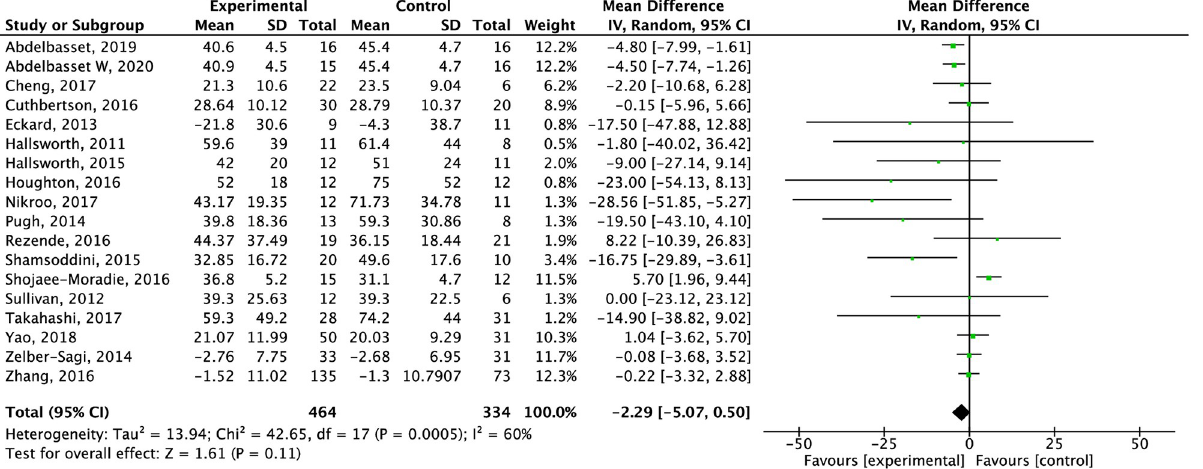
PLOS ONE | https://doi.org/10.1371/journal.pone.0263931 February 17,